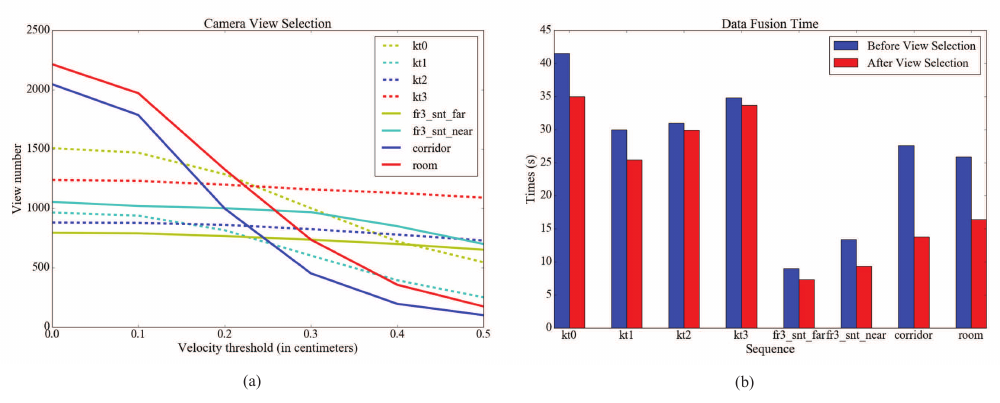
Figure 3. The variation of the number of camera views and data fusion time. ( a ): variation of the number of camera views before and after view selection with different velocity thresholds. ( b ): variation of data fusion time before and after view selection (ICL-NUIM and our datasets: v = 0.2; TUM RGB-D dataset: v = 0.5).